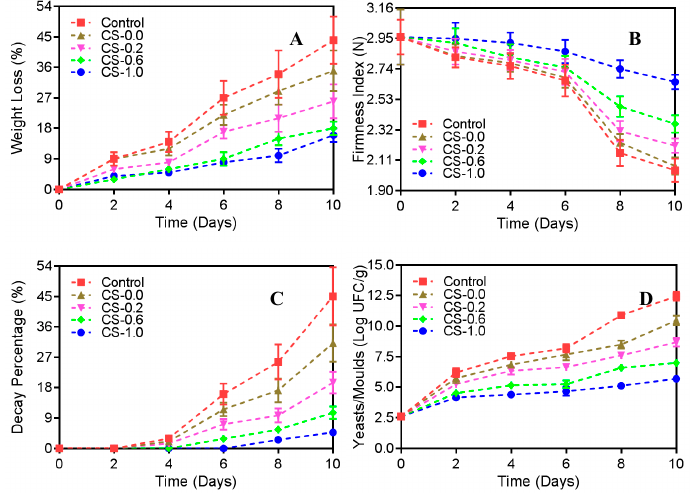
Figure 2. Weight loss ( A ), firmness index ( B ), decay percentage ( C ), and yeasts/molds ( D ) of strawberries during refrigeration storage (10 days). Control, strawberries packed without CS films; CS-0.0, strawberries packed with CS film CS-0.0; CS-0.2, strawberries packed with CS film CS-0.2; CS-0.6, strawberries packed with CS film CS-0.6; CS-1.0, strawberries packed with CS film